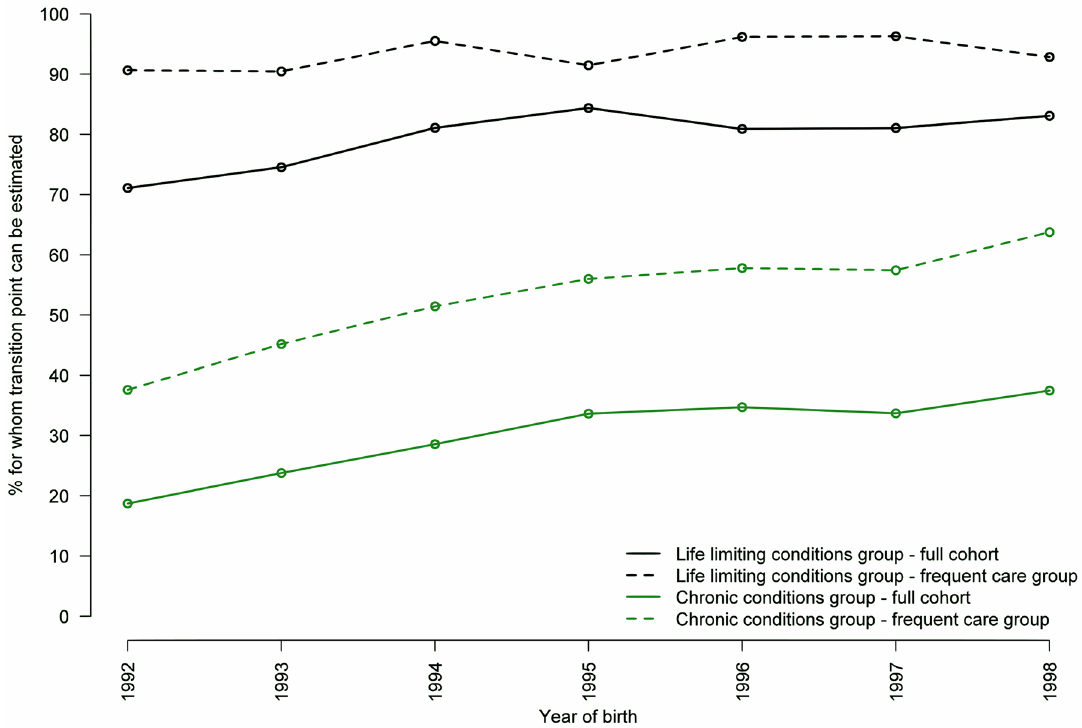
Figure 5: Proportions of children and young people for whom transition point can be estimated (i.e. the proportion having both paediatric and adult